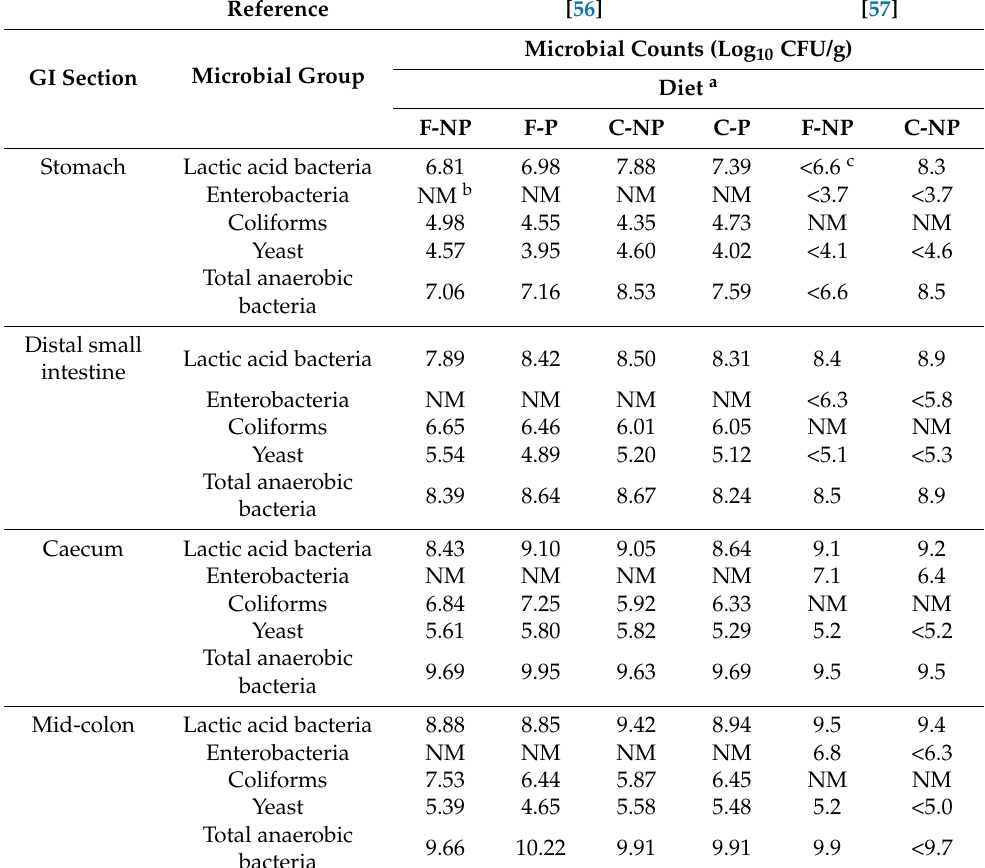
Table 3. Microbiological counts (log 10 CFU/g) in the gastrointestinal contents of pigs fed either meal or pelleted diets (finely or coarsely ground)